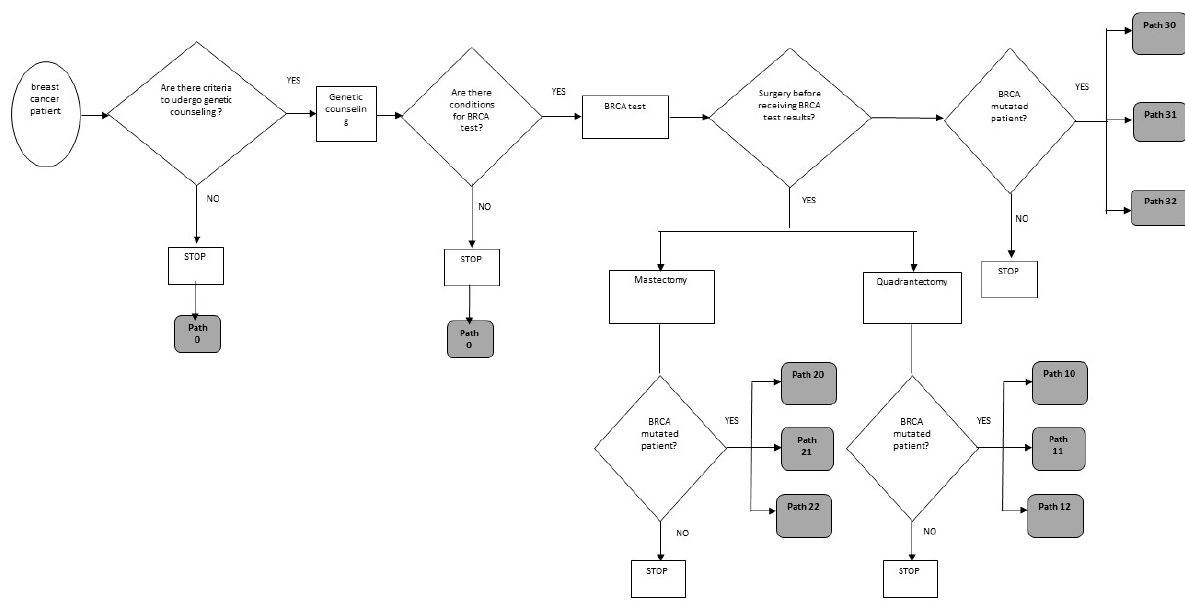
Figure 1. Model schematic/flow chart (a detailed description of the therapeutic paths is reported in the Appendix A).